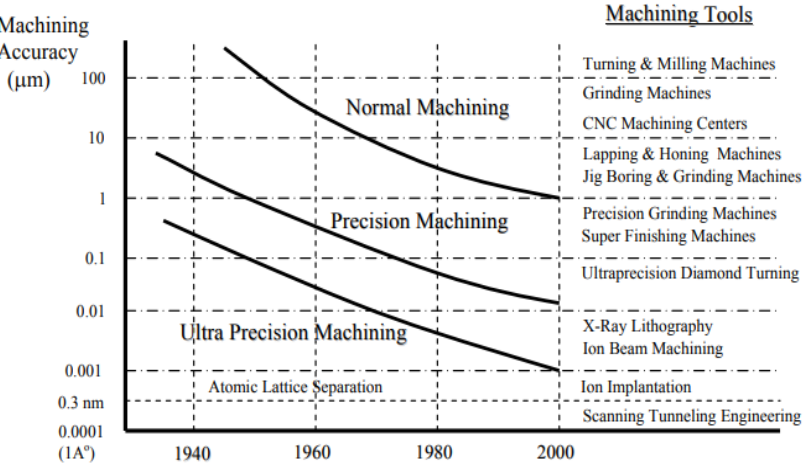
Figure 3. The machining accuracy of different traditional and advanced machining processes [27]. A summary of loose abrasive-based machining processes about their basic principle and process parameters is shown in Table 1.